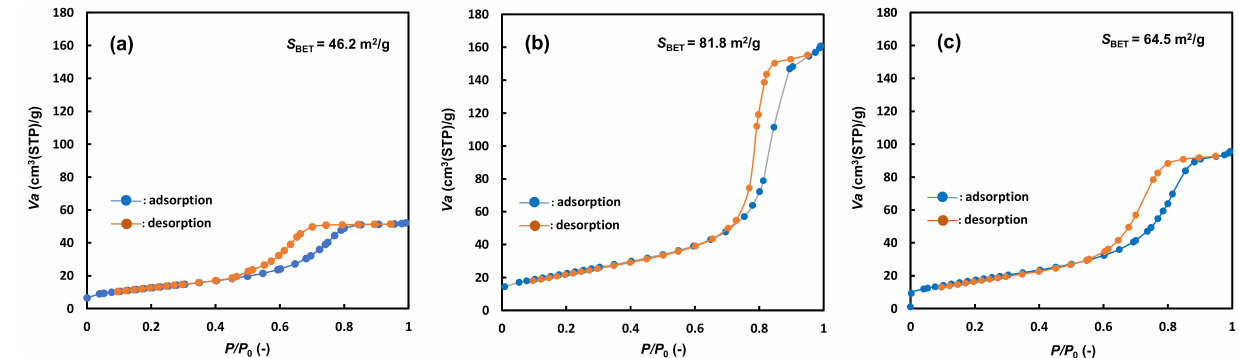
Figure 4. N 2 isotherms of ( a ) NFT, ( b ) NAT, and ( c )